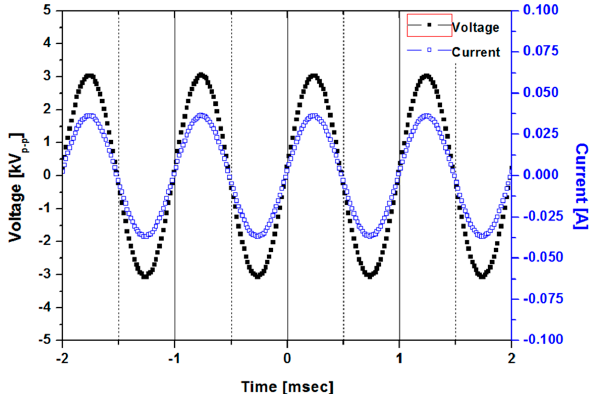
Figure 2. Waveforms of the input voltage and current (6 kV input voltage case).